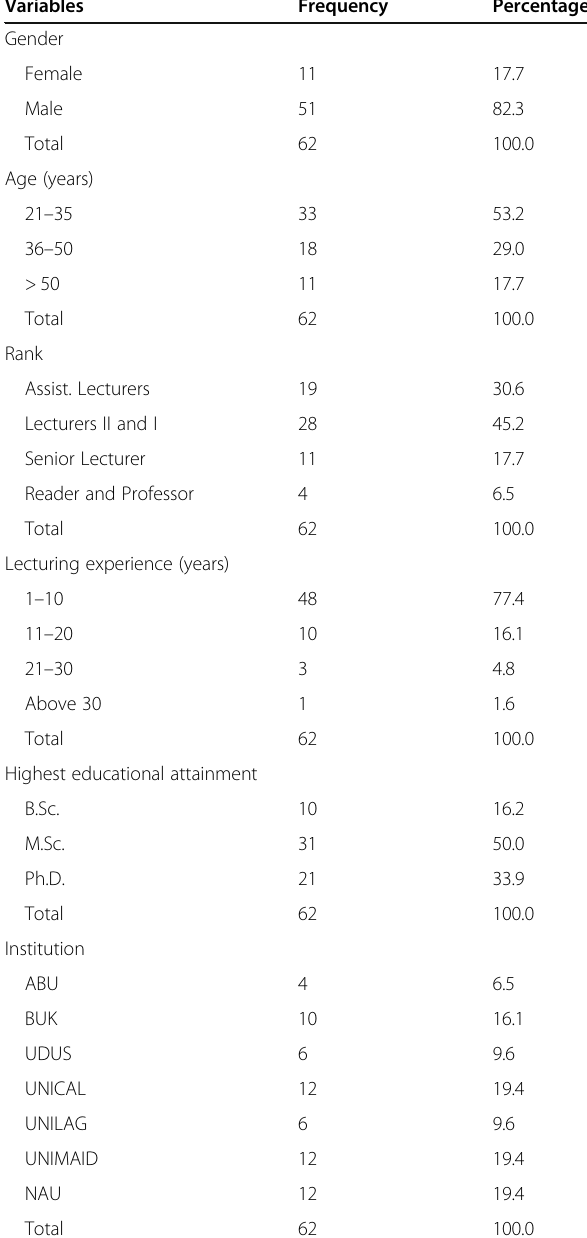
Table 1 Demographic data of the